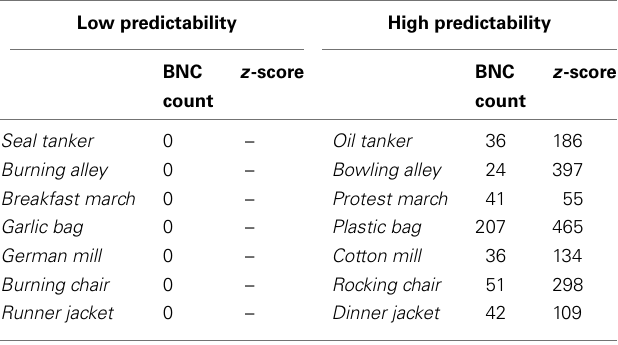
Table 1 | Phrase pairs used in the semantics